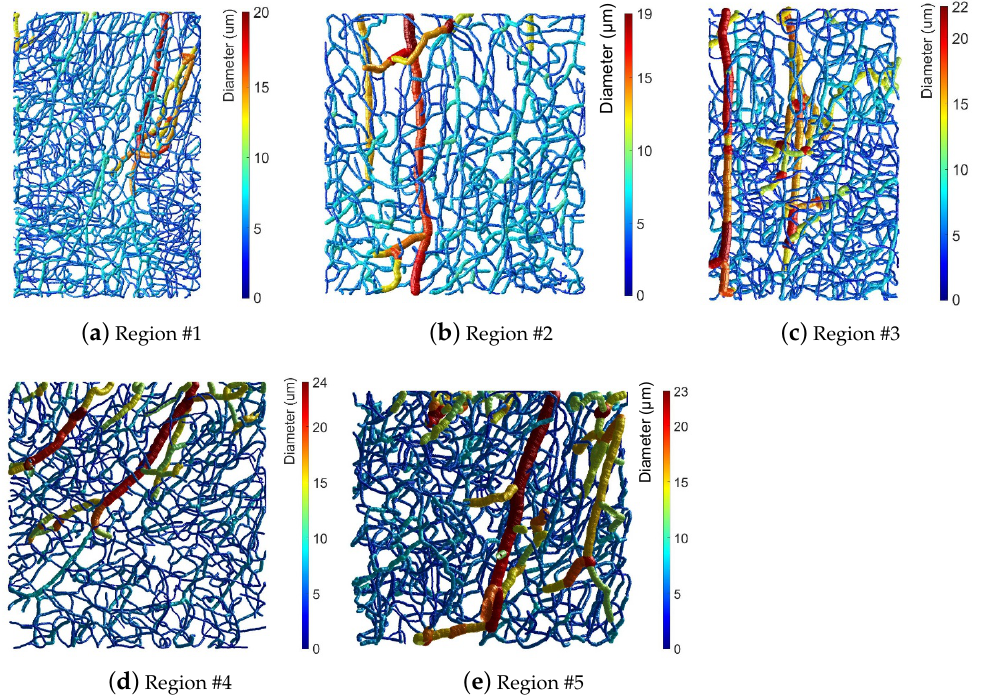
Figure 5. Morphology of the 5 cerebrovascular regions of the murine cortex considered in this study. The heat map represents by color the distribution of the value of the diameters within the microcirculatory synthetic